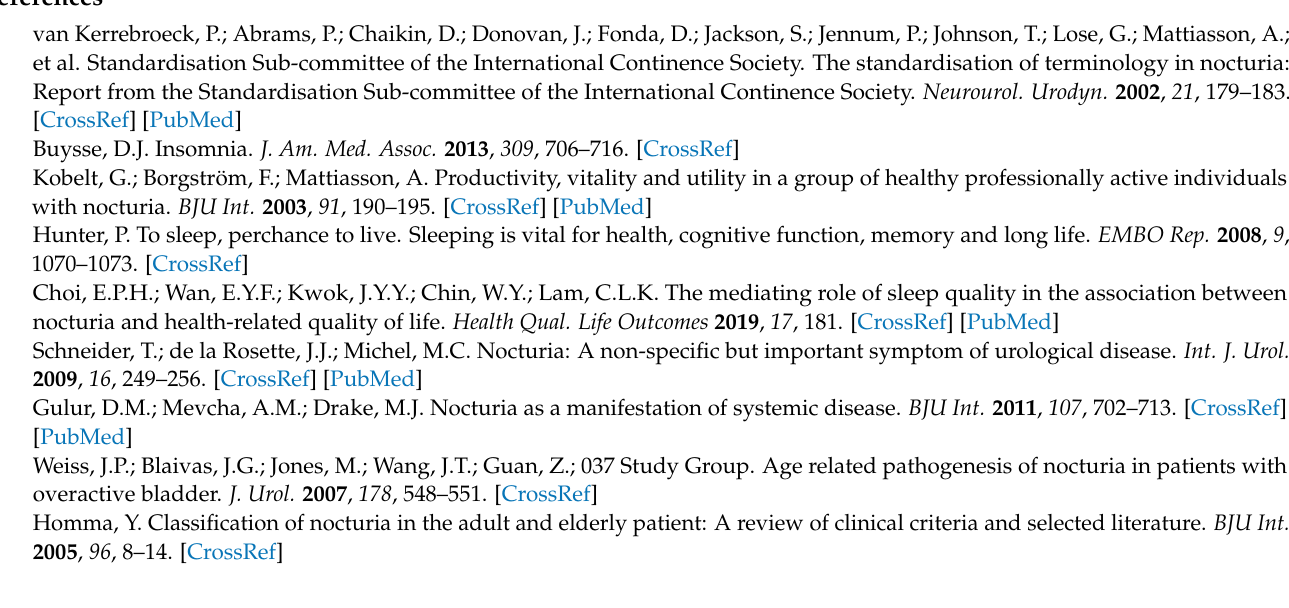
Figure A2. The EuroQol visual analog scale (EQ-VAS).